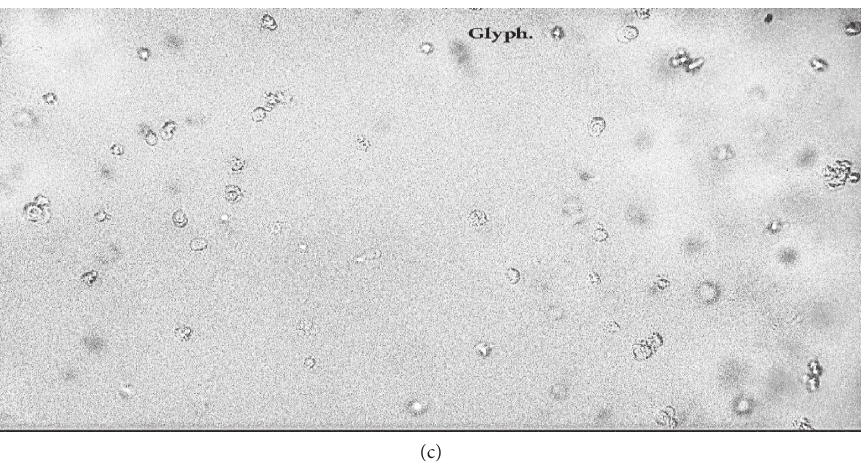
Figure 2: Pesticides-induced morphological changes in WPM-Y.1 cells. WPM-Y.1 cells were seeded in 12-well plates and allowed to grow for 20h. Thereafter, cells were exposed to the IC 50 level, 0.023 and 0.025mM of imidacloprid and glyphosate, respectively, for 24h. Significant alterations were induced in cell membranes and destructed their cytoplasm and microvilli which appeared as desorbed cells. The morphological changes were analyzed using the LABOMED inverted microscope, USA. Images selected were performed with a mag- nification of